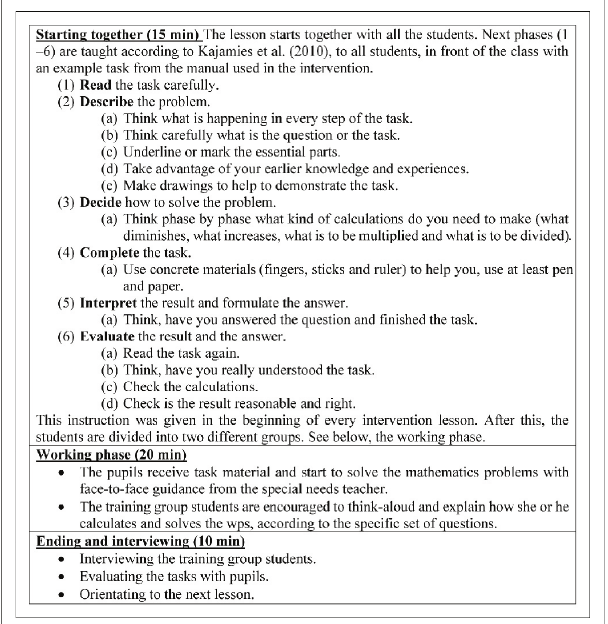
FIGURE 1-A1: A sample lesson plan of an intervention lesson (45